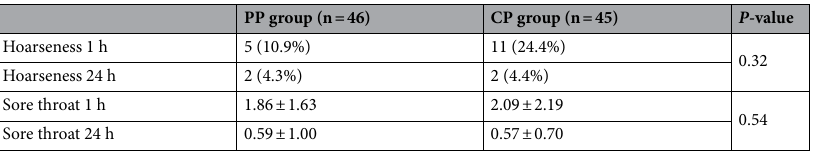
Table 3. Complications associated with intubation. Continuous variables are presented as mean ± SD. Nominal variables are presented number (frequency).